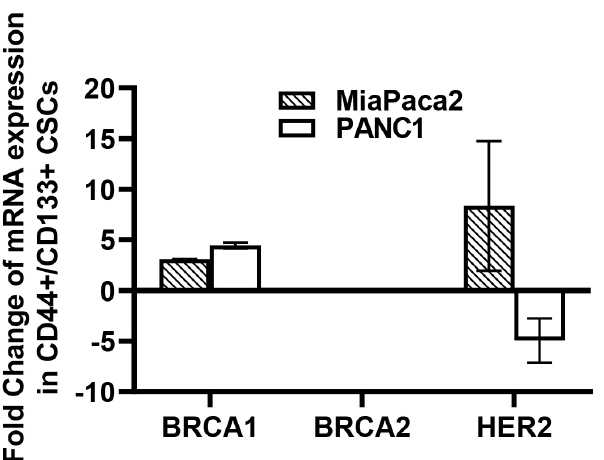
Figure 4. Differential expression of BRCA1, BRCA2, and HER2 mRNA transcripts in CD133+/CD44+ CSCs isolated by the PDAC cell lines MiaPaca2 and PANC1. For gene microarray analysis, Agilent Array platform was employed. Quantile normalization and subsequent raw data processing were performed using the GeneSpring GX v11.5.1 software package (Agilent Technologies). Differentially expressed mRNAs between compared samples (CD44+/CD133+ vs. CD44-/CD133-) of each cell line were identified through fold change (FC) filtering (FC ≥ 2 was set as a cut-off value). Columns represent mean fold change of gene expression ± SDEV.